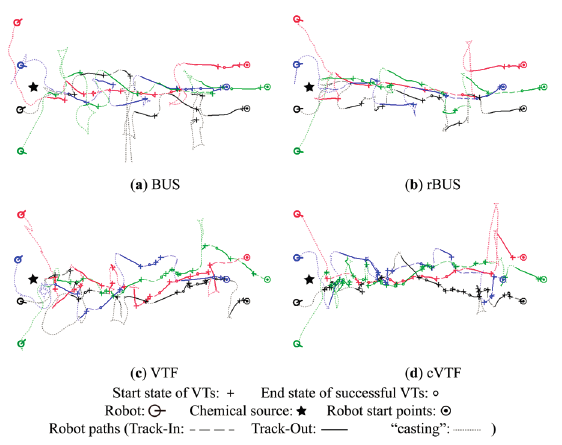
Figure 14. Typical robot trajectories obtained in S group.